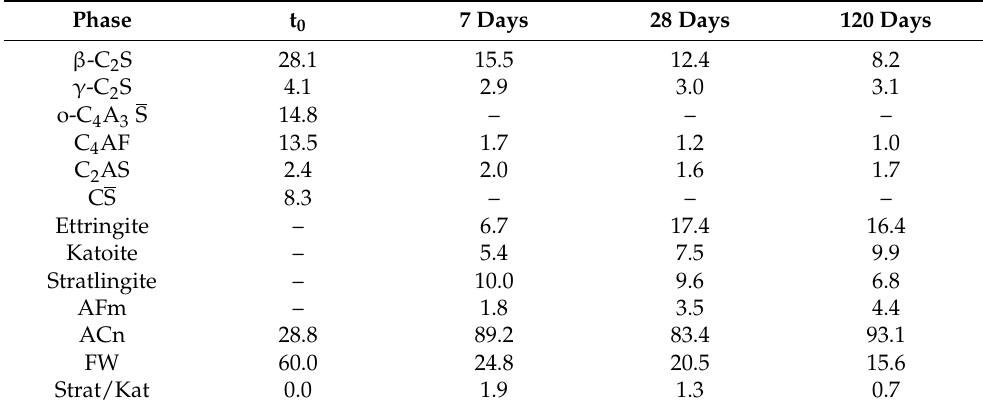
Table 5. RQPA, including ACn and FW of st-BYF with w/c = 0.60 (st-BYF-wc060), per 100 g of anhydrous cement. Stratlingite/katoite ratio is also included.